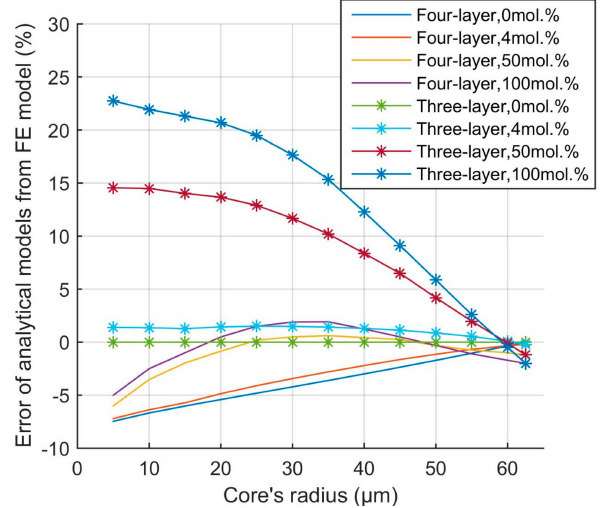
Figure 7. Errors of four- and three-layer models from finite-element (FE)